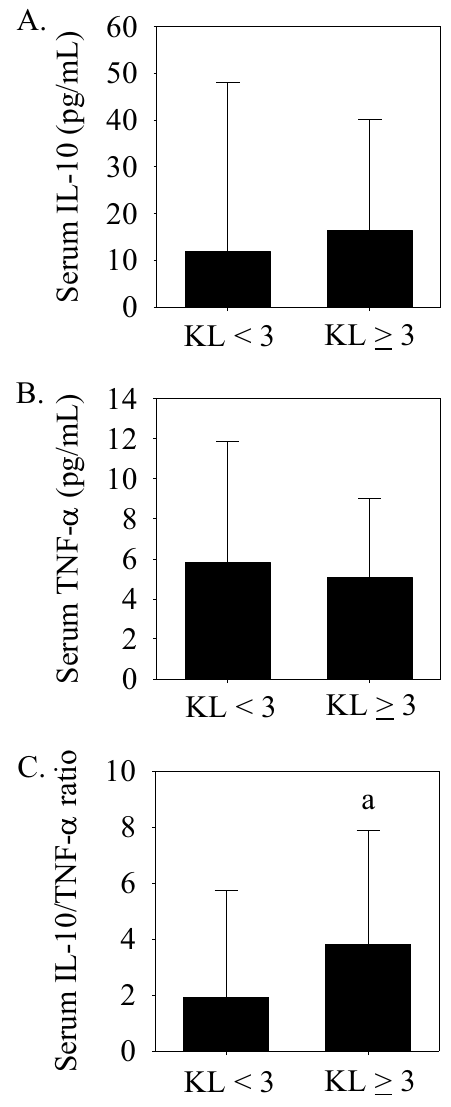
Figure 2. Serum IL-10 and TNF-α concentrations and the serum IL-10/TNF-α ratio without (KL grade < 3, n = 51) and with (KL grade ≥ 3, n = 79) radiographic evidence of knee joint space narrowing. ( A ) Serum IL-10 and ( B ) Serum TNF-α concentrations were not significantly different between groups. ( C ) The serum IL-10/ TNF-α ratio was significantly ( a p < 0.05 vs. KL grade < 3) higher in the KL grade ≥ 3 group. Data presented as median (interquartile